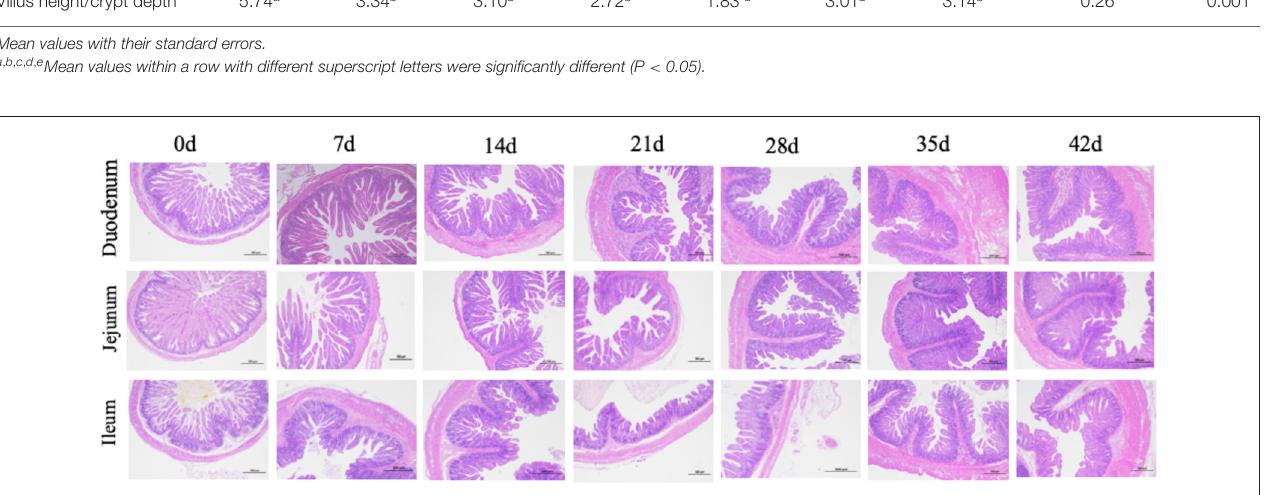
FIGURE 1 | Histological evaluation of small intestine tissue in piglets with increasing